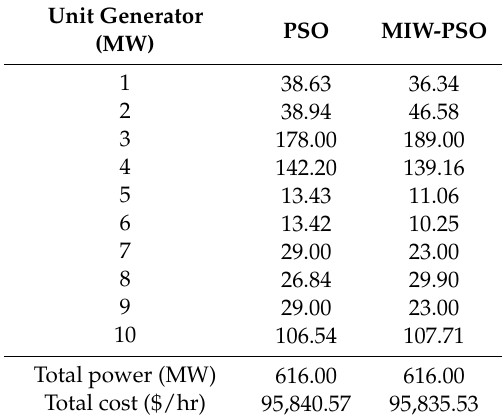
Table 13. Generator unit capacity and coefficients on fifth case study.